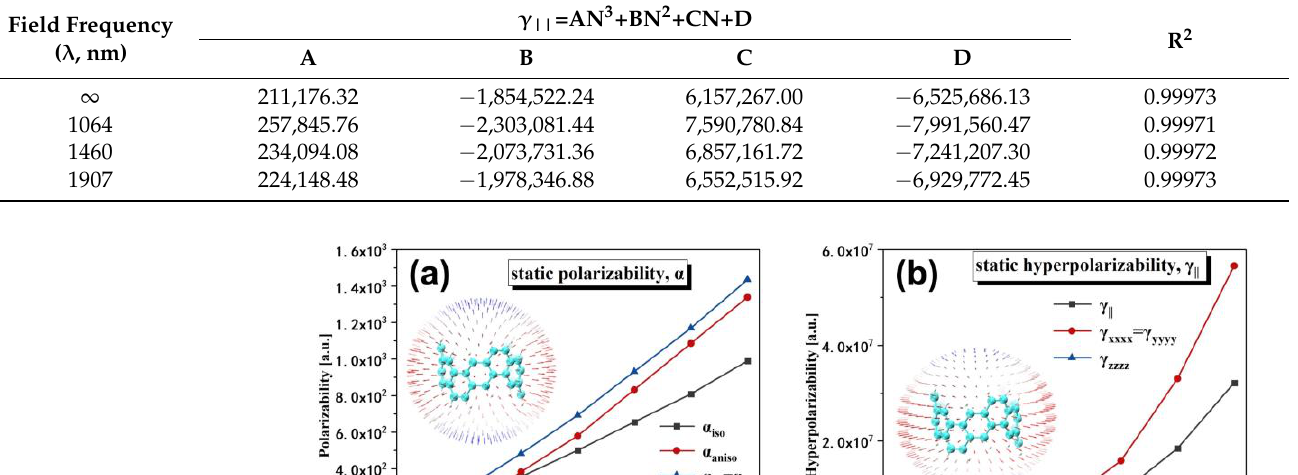
Table 2. The extrapolation formula of the second hyperpolarizability of [2N,2N]CNB under different external fields.